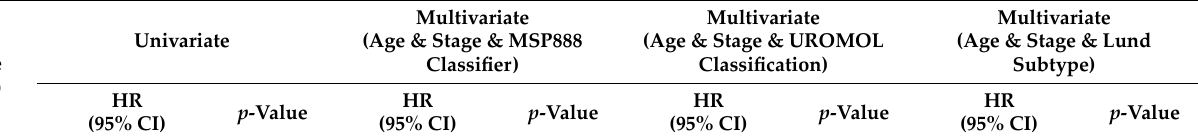
Table 6. Univariate and multivariate Cox regression analyses for predicting progression of NMIBC in patients in the UROMOL cohorts not treated with BCG